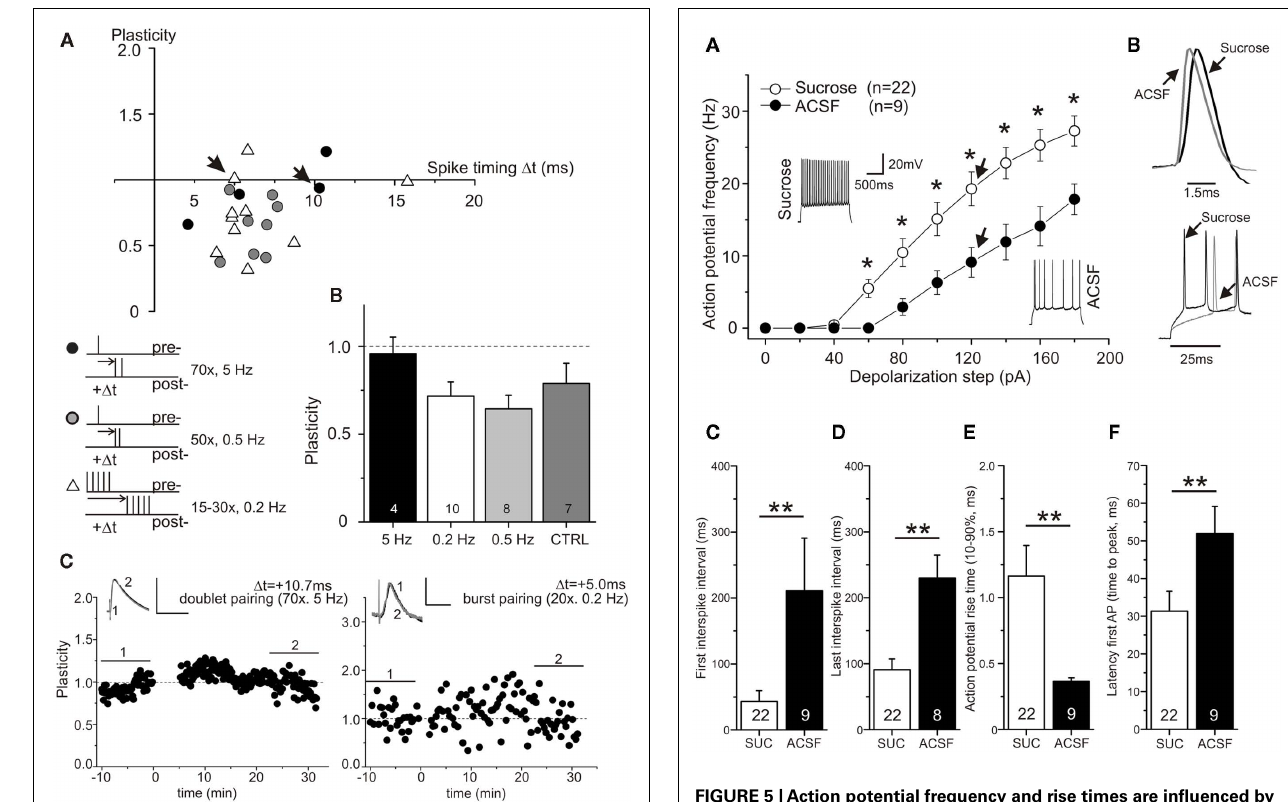
FIGURE 5 |Action potential frequency and rise times are influenced by sucrose preparation. CA1 pyramidal neurons were recorded in the current clamp mode and action potentials were induced by current injection. Membrane potential was − 70mV prior to stimulation. (A) Sucrose preparation led to a significant increase in action potential frequency compared to preparation in ACSF ( p < 0.05, ANOVA).Typical original traces are shown for both conditions (1s depolarization at 120pA). (B) Representative original traces for rise time and latency differences are shown for a 120 pA current injection for neurons of sucrose and ACSF prepared slices. Spike adaptation (C) at the beginning of the spike train and (D) at the end of the spike train was diminished in sucrose prepared hippocampal slices (** p < 0.01, 120pA depolarization). (E) Action potential rise time (10–90% of peak amplitude) was significantly prolonged after sucrose preparation compared to ACSF (** p < 0.01, 120pA constant current injection). (F) Changed latency to first action potential (in ms) in response to 120pA current injection in sucrose and ASCF group of slice preparation (** p < 0.01, Mann–Whitney U